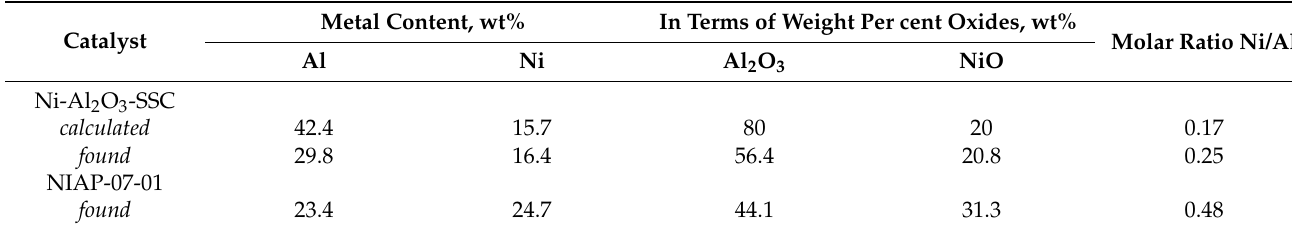
( a ) ( b ) Figure 5. Thermal analysis data for ( a ) Ni-Al 2 O 3 -SSC and ( b ) NIAP-07-01 catalysts (helium, 10 °C·min − 1 ). Besides, the low aluminum content (Table 1) can be associated with phase inhomo- geneity of catalysts, especially for an industrial NIAP-07-01 catalyst. Its XRD pattern contains an intense peak of graphite (at angle 26.5°), as well as weak intensity peaks at low angles (2 θ = 20.4, 23.1°), which could not be interpreted unambiguously. Moreover, for NIAP-07-01, there is an increase of spinel cell parameter of alumina (Table 2), proba- bly due to the intercalation of nickel cations with a larger ionic radius than Al 3+ . Table 2. The phase composition of Ni-Al 2 O 3 -SSC and NIAP-07-01 catalysts. Sample Phase